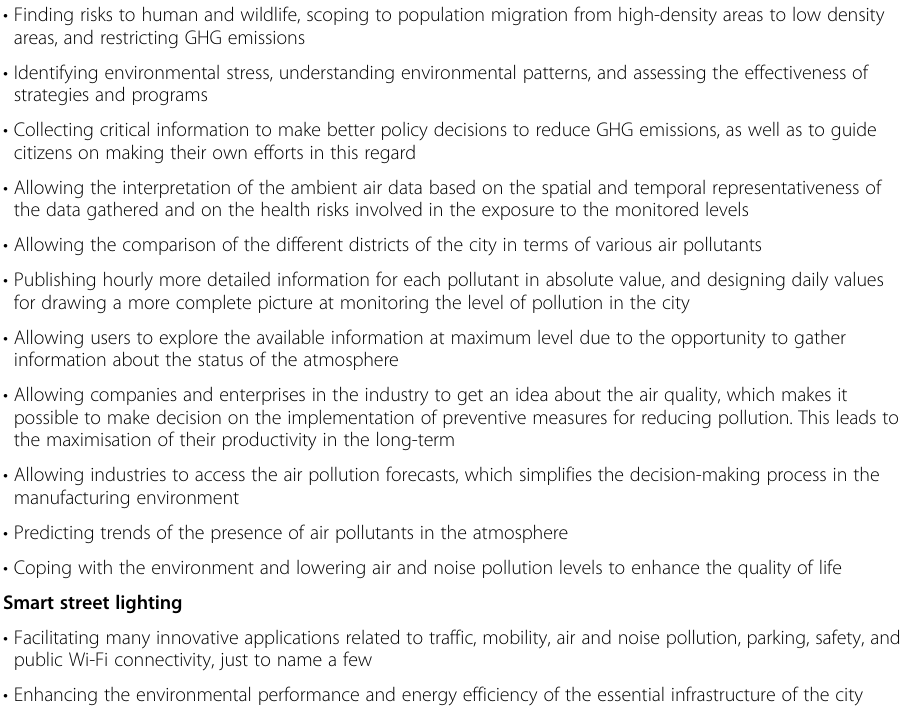
Table 6 The key benefits, potentials, and opportunities of the data-driven smart city and the environmentally data-driven smart sustainable city